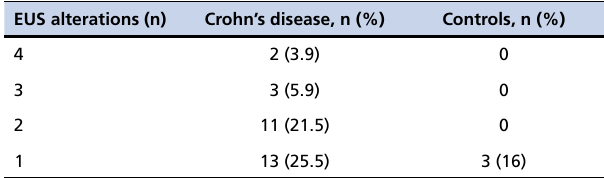
Table 1 – Epidemiological features of Crohn’s disease patients. Table 2 – Endoscopic ultrasound findings*.